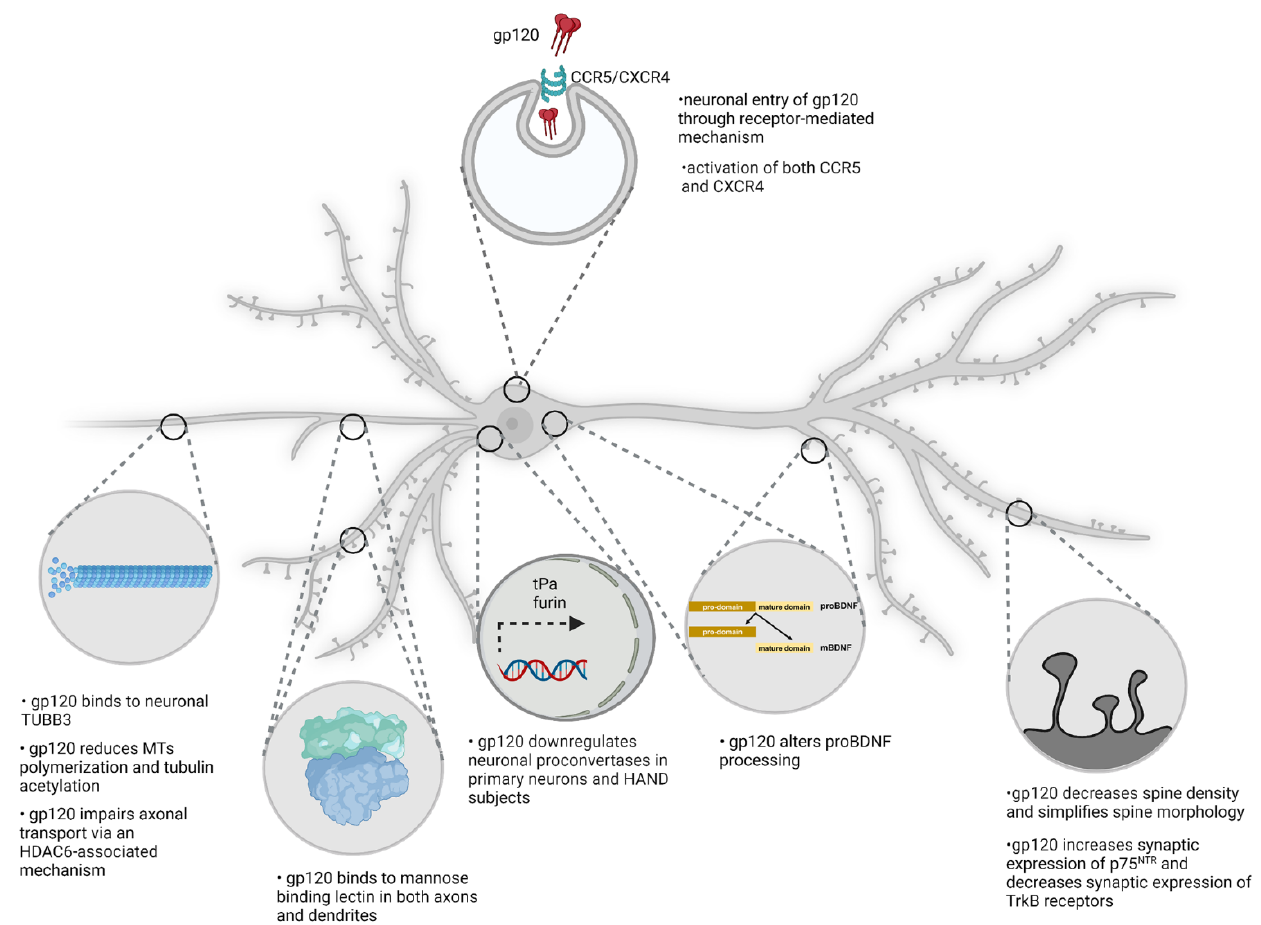
Figure 3. Proposed mechanism of gp120-mediated decrease in spine density. gp120 binds and activates co-receptors CXCR4 or CCR5. These receptors are critical for gp120 endocytosis. Once inside neurons, gp120 binds to microtubules and changes the post-translational modification of tubulin, which could result in axonal damage. Internalized gp120 is also transported by axons or dendrites back to the Golgi apparatus via a mannose-binding lectin. In the Golgi apparatus, gp120 down-regulates the activity of furin, which results in decreased processing of proBDNF to mature BDNF. When proBDNF is released, it binds to p75NTR and causes a loss of dendritic spines.